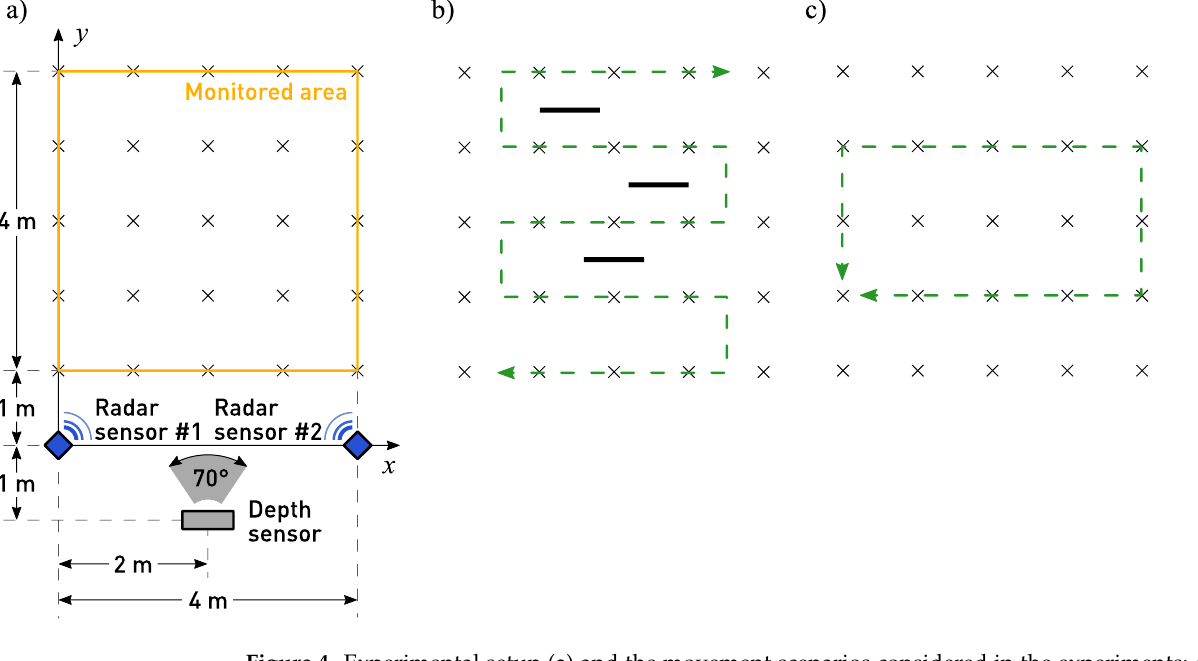
Figure 4. Experimental setup ( a ) and the movement scenarios considered in the experiments: the serpentine trajectory used in EXP#1 ( b ), and the rectangle-shaped trajectory used in EXP#2 ( c ). The reference points, i.e., the points where marks have been placed on the floor, are indicated with crosses.